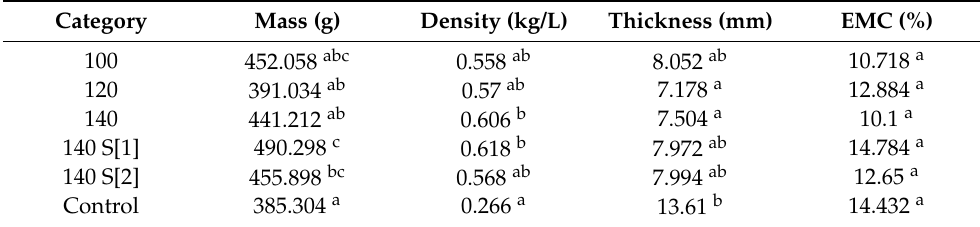
Table 2. Tukey’s HSD test results for main